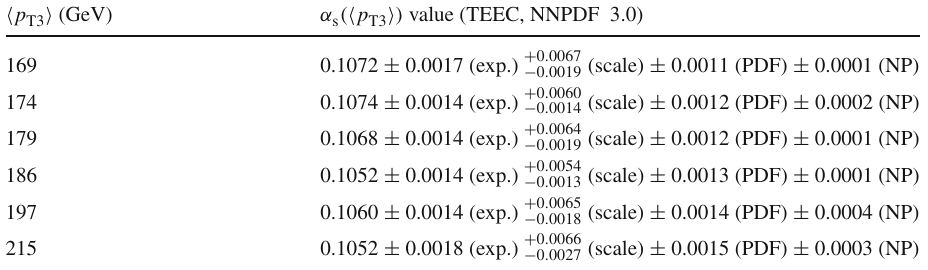
(cid:4) p (cid:5) T3